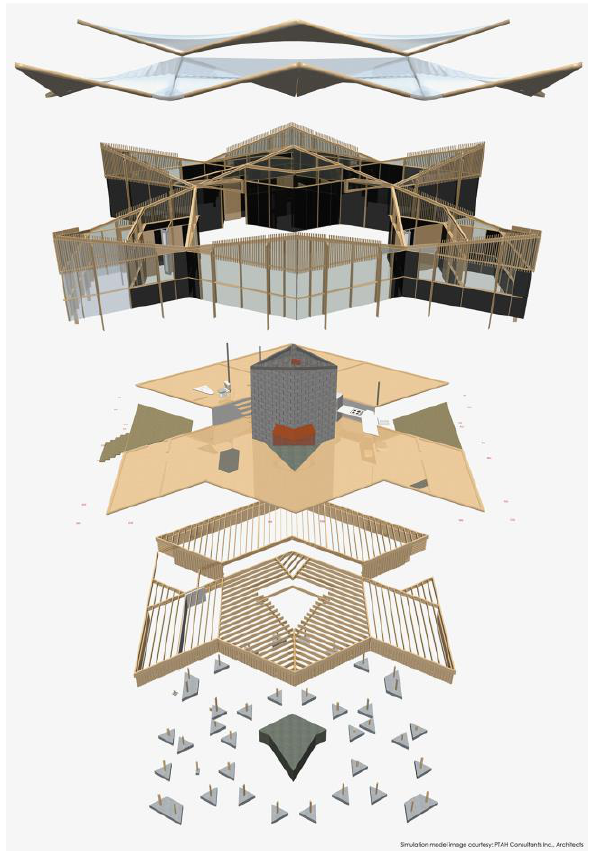
Figure 3. Image extraction from Building Simulation Model of the HSR (©PTAH Consultants Inc. Architects)